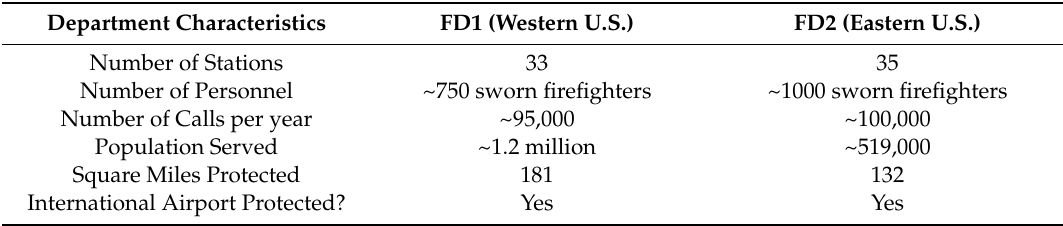
Table 1. Comparison of participating fire